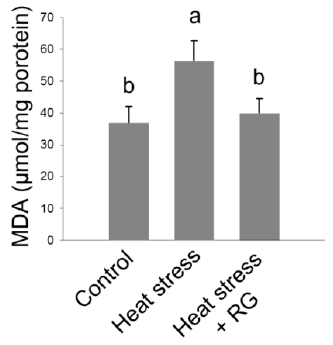
Figure 6. Effects of heat stress and Red ginseng extracts (RG) on lipid peroxidation in rat livers. The results are expressed as means ± standard deviation ( n = 3). Values with different letters are significantly different, p < 0.05.